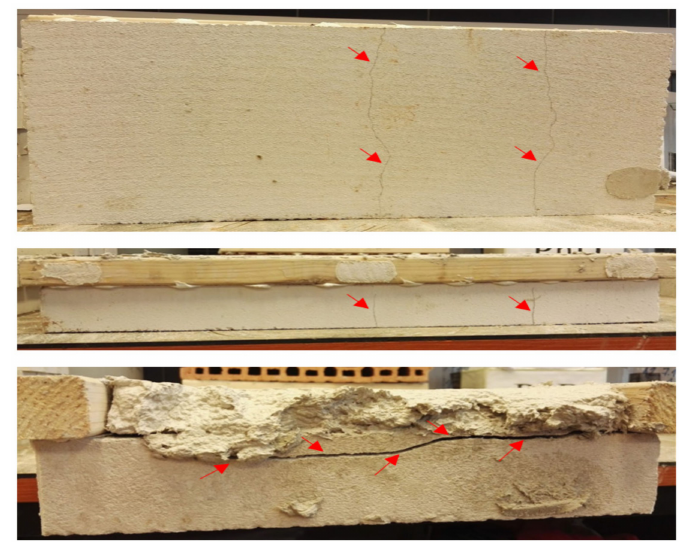
Figure 22. Damage of an aerated concrete block substrate with the C9 plaster